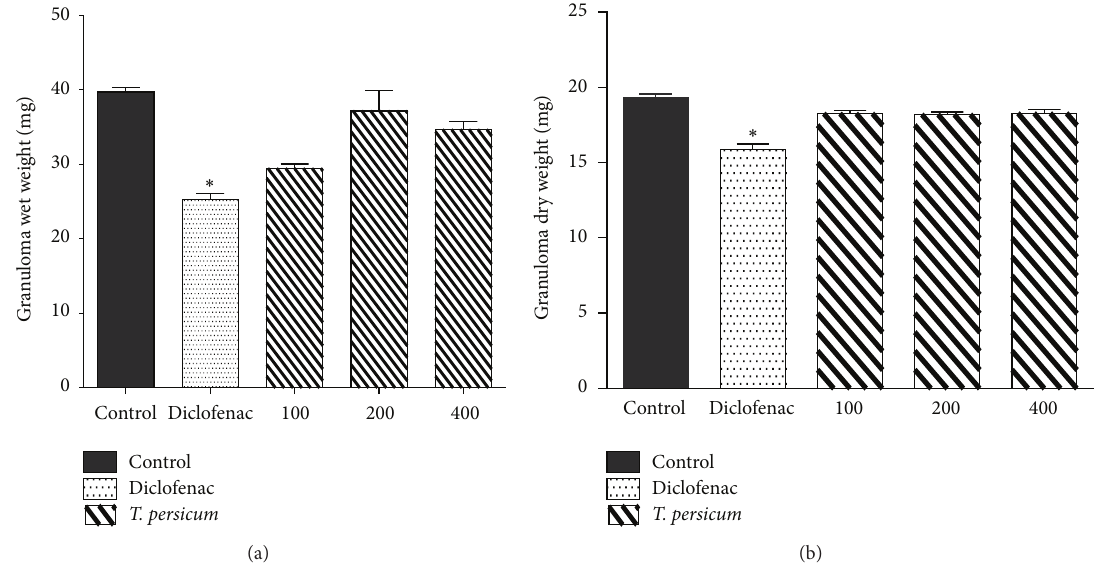
Figure 7: Anti-inflammatory activity of T. persicum in cotton pellet-induced granuloma formation. (a) Granuloma wet weight and (b) granuloma dry weight. ∗ 𝑃 < 0.05 , significantly different from the control animals. Each value represents the mean ± SEM ( 𝑛 = 8